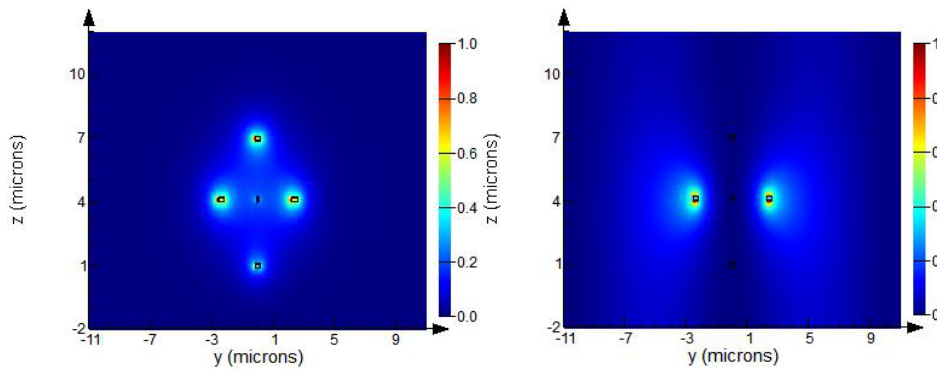
Figure 3. The fundamental TE and TM mode at the chip facet for the designed edge coupler. Table 1. Optimized parameters of the designed edge coupler. Dimension